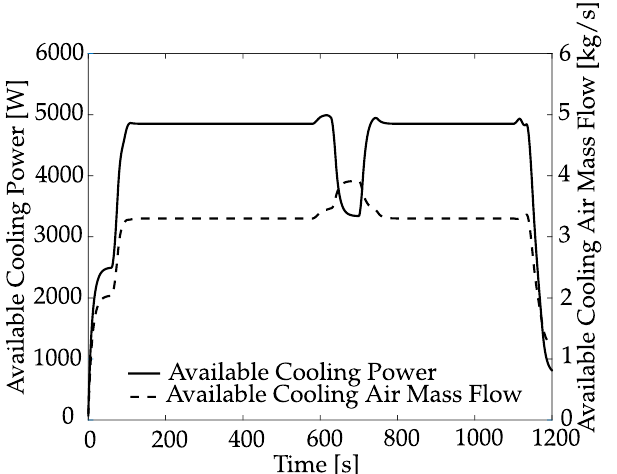
Figure 7. ECS model available cooling power (solid) and the available coolant mass flow as (dashed) for the OpsCon simulations.